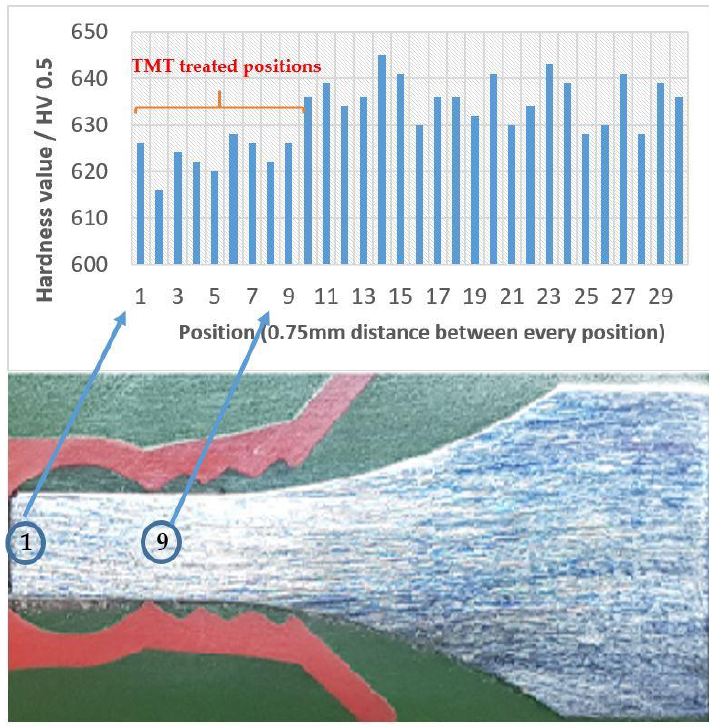
Figure 3. Influence of the TMT on the specimen